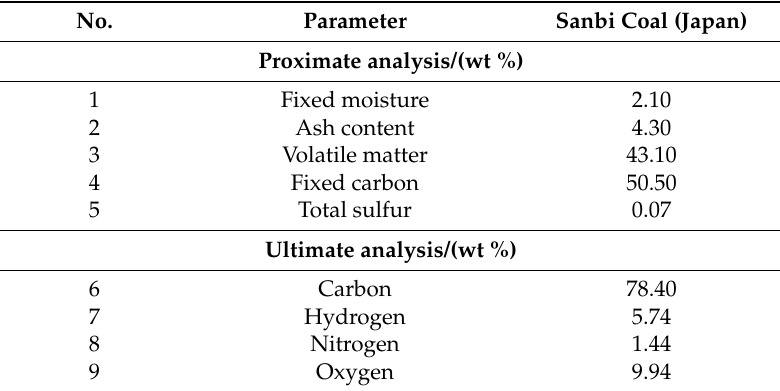
Table 1. Proximate and ultimate analysis of coal